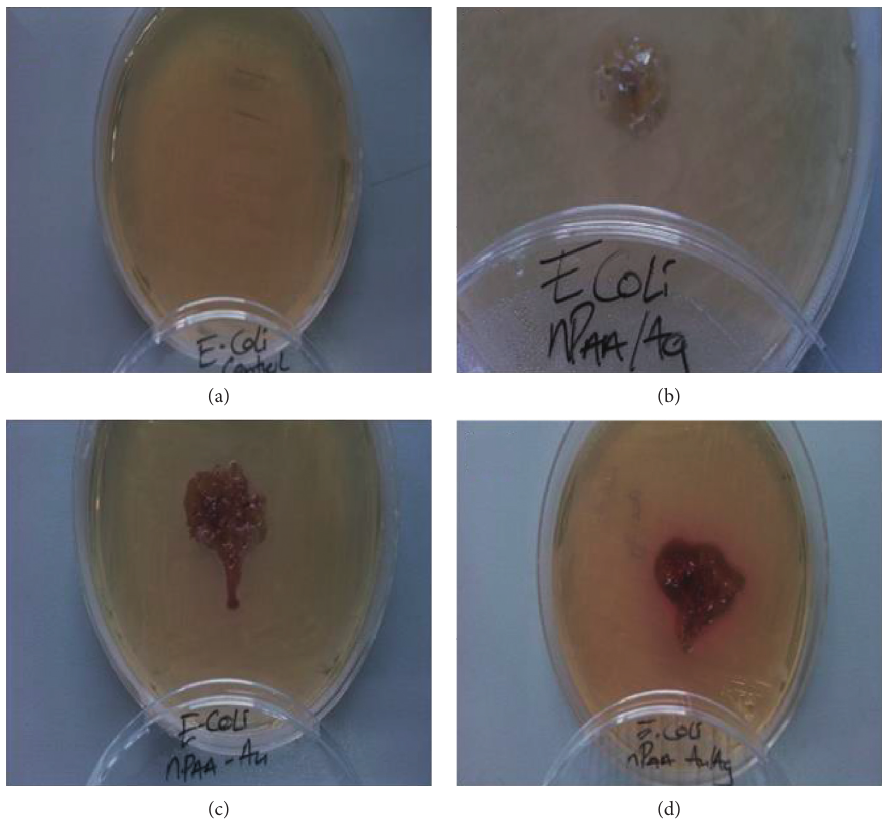
Figure 8: Investigation of the antimicrobial activity of different PAA solutions against E. coli . (a) Control plate with Muller Hinton agar and inoculated E. coli bacteria. (b) Plate treated with AuNPs-PAA. (c) plate treated with AgNPs-PAA. (d) Plate treated with Au/AgNPs-PAA demonstrating a larger zone of inhibition than the plate treated with